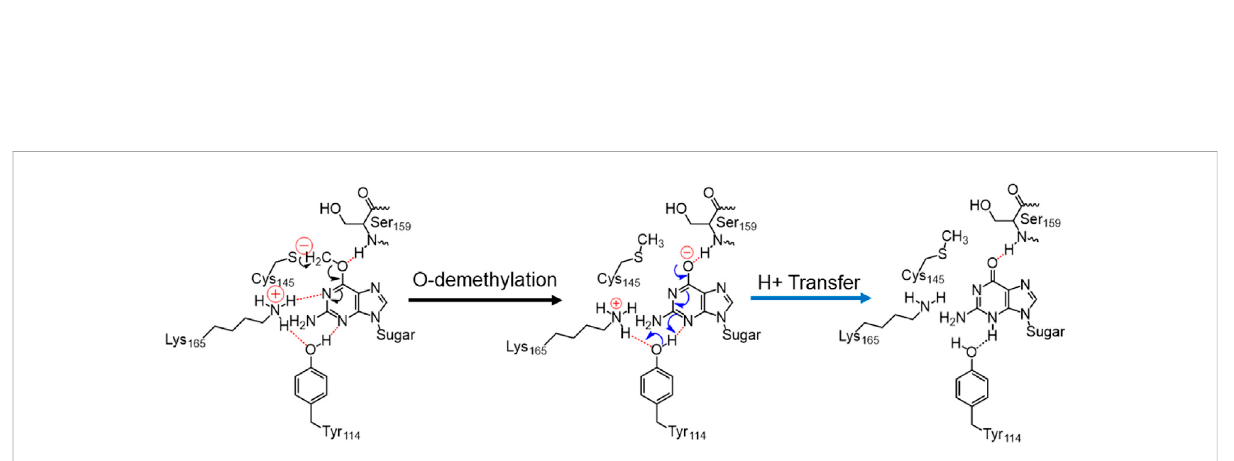
SCHEME 2 Final mechanism of direct repair of m-GUA by